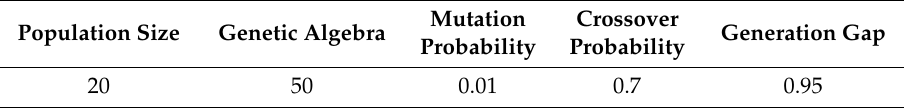
Table 4. Genetic algorithm parameter settings.